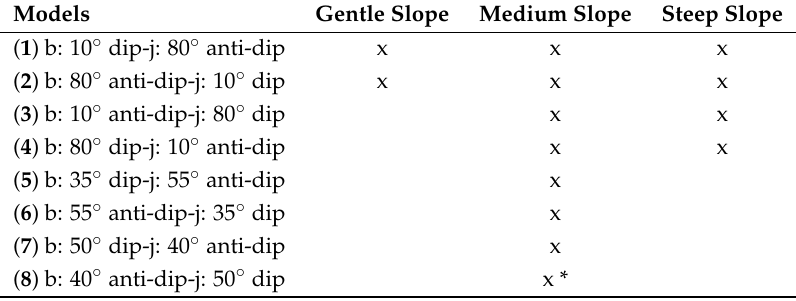
Table 4. Bedding and joint structures simulated in UDEC for each slope (b = bedding and j = joints). Models Gentle